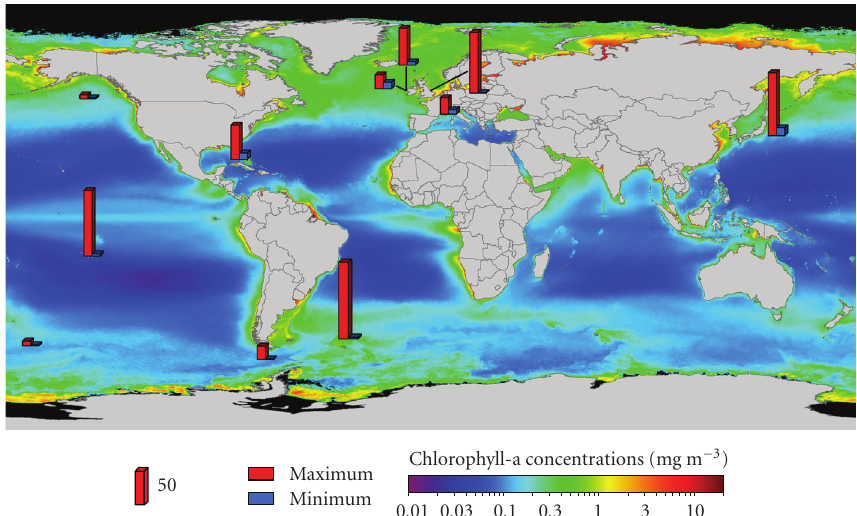
Figure 1: Marine Isoprene Seawater Concentrations. Concentrations in pmol/L. All values reported in the corresponding table are included, except for global modeling studies for which individual locations were not reported. Only “out of bloom” values reported for fertilization experiments. Representative lat./long. coordinates chosen when necessary. Figure background shows SeaWiFS retrieved surface [Chl- α ]. Figure 1 only: Two high points removed [20, 28] to bring all other points in